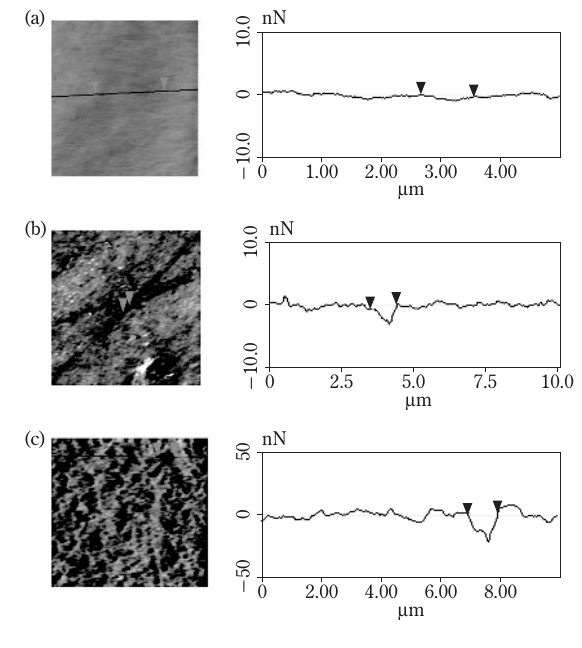
Surface response quality of the silica wafers polished with a) Baseline Rodel 1200 slurry, b) Rodel 1200 slurry spiked with 1%w 1.5 µ m size Geltech particles and c) Polymer floc- culated 0.2 µ m size, 12%w Geltech